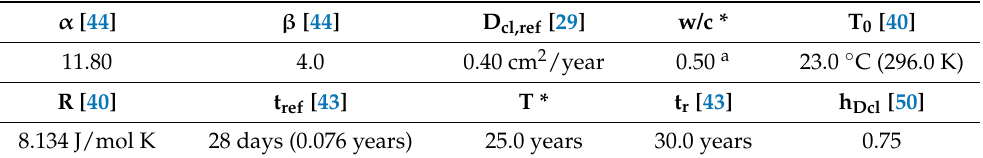
Table 1. Deterministic